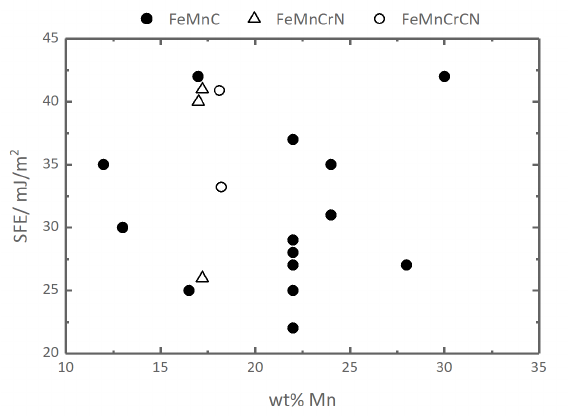
Figure 6. SFE of various austenitic steels. FeMnC: [67–72]; FeMnCrN: [71,73]; FeMnCrCN: [74]. For exact chemical compositions see Table A1 in Appendix